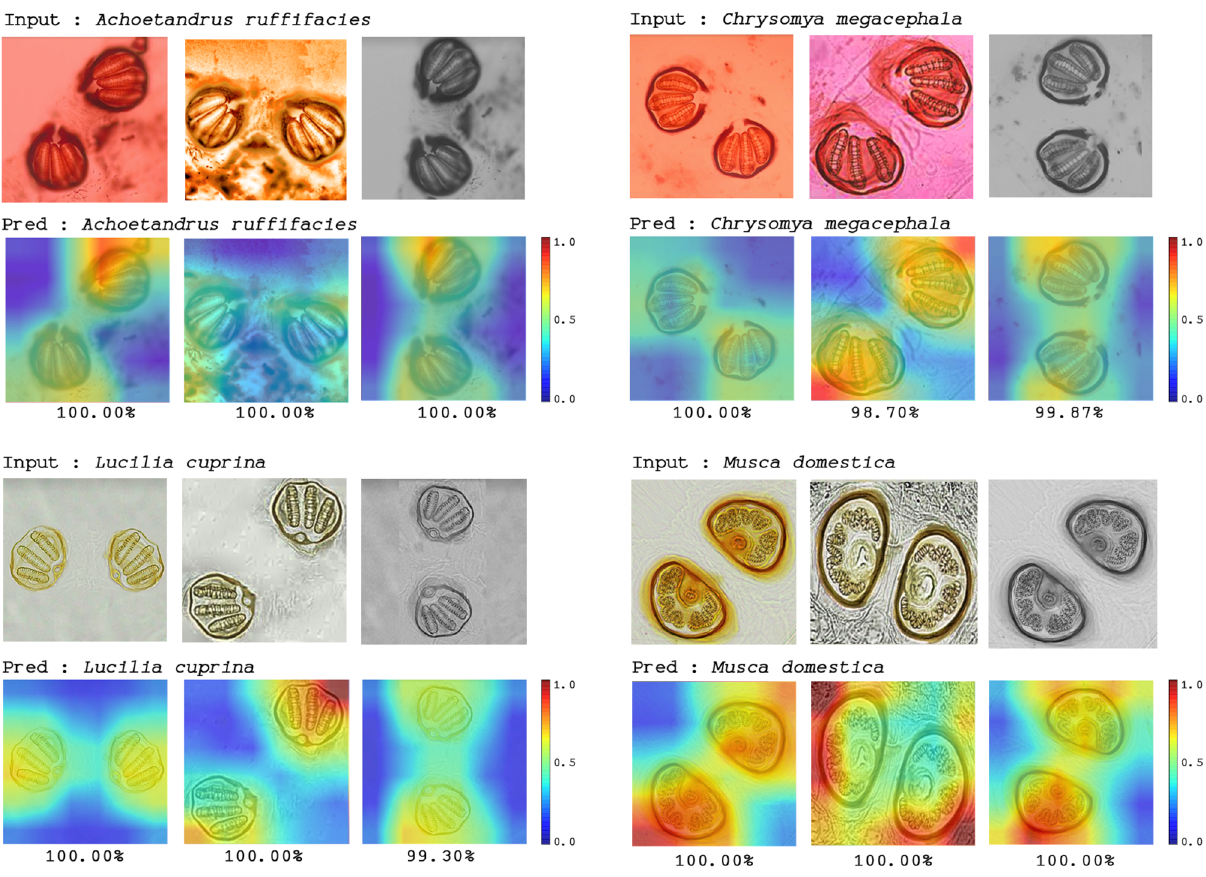
Figure 6. Heatmap of attention maps of AlexNet on example images showing prediction accuracy (98.70– 100%) of this model for classification of each fly species in different image